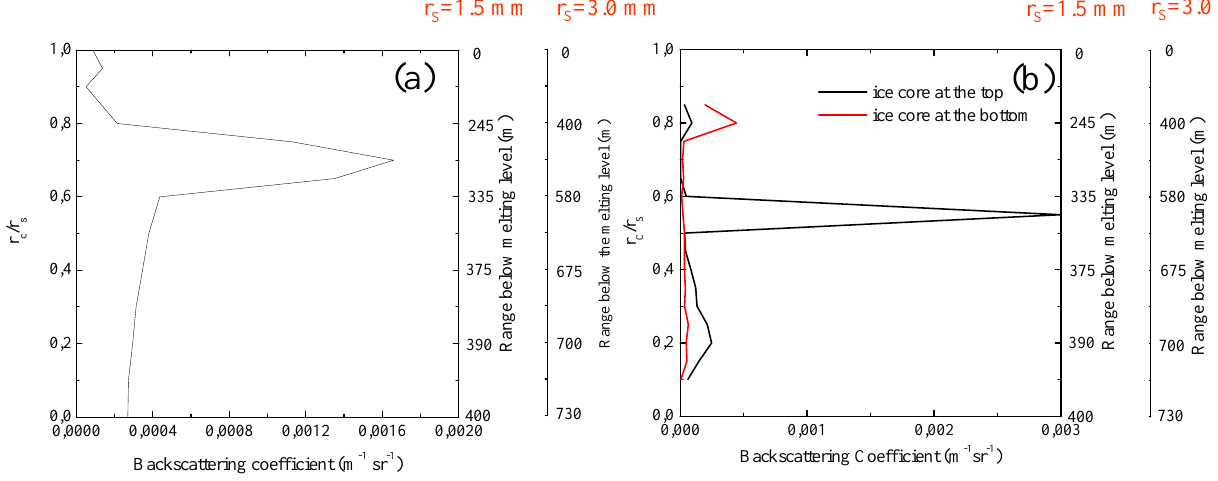
Fig. 8. Volume backscattering coefficient at 350nm vs. melting ratio r c /r s . (a) shows the results obtained with the concentric sphere model, while (b) shows the results obtained with the eccentric sphere model, with the black line indicating the simulation for the hydrometeor with the ice core at the top of the water shall and the red line the hydrometeor with the ice core at the bottom of the water shall.